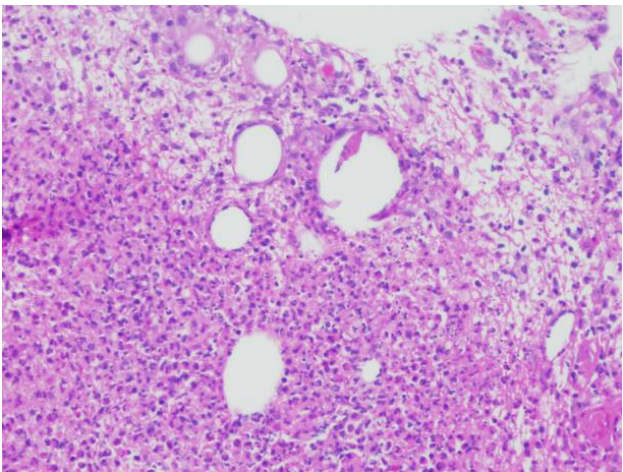
Figure 1. Hematoxylin and eosin staining at 20× magnification, showing cystic spaces with granu- lomatous inflammation and mixed neutrophilic and lymphohistiocytic